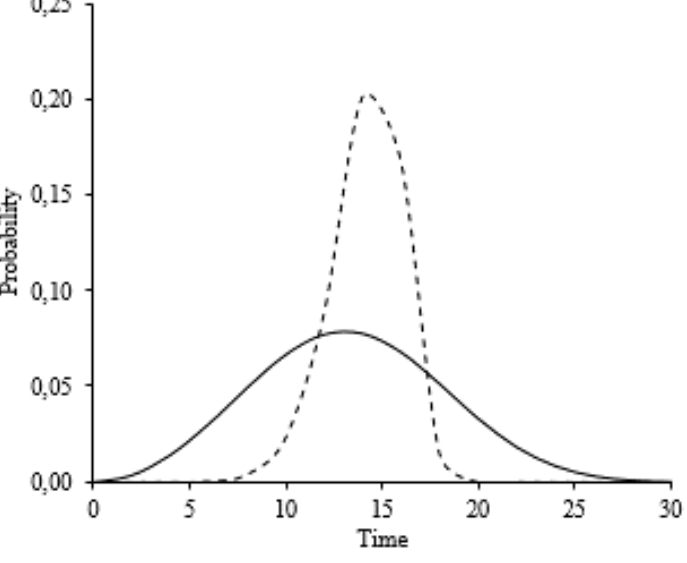
Figure 2. PDF representation of two components of HVAC system.